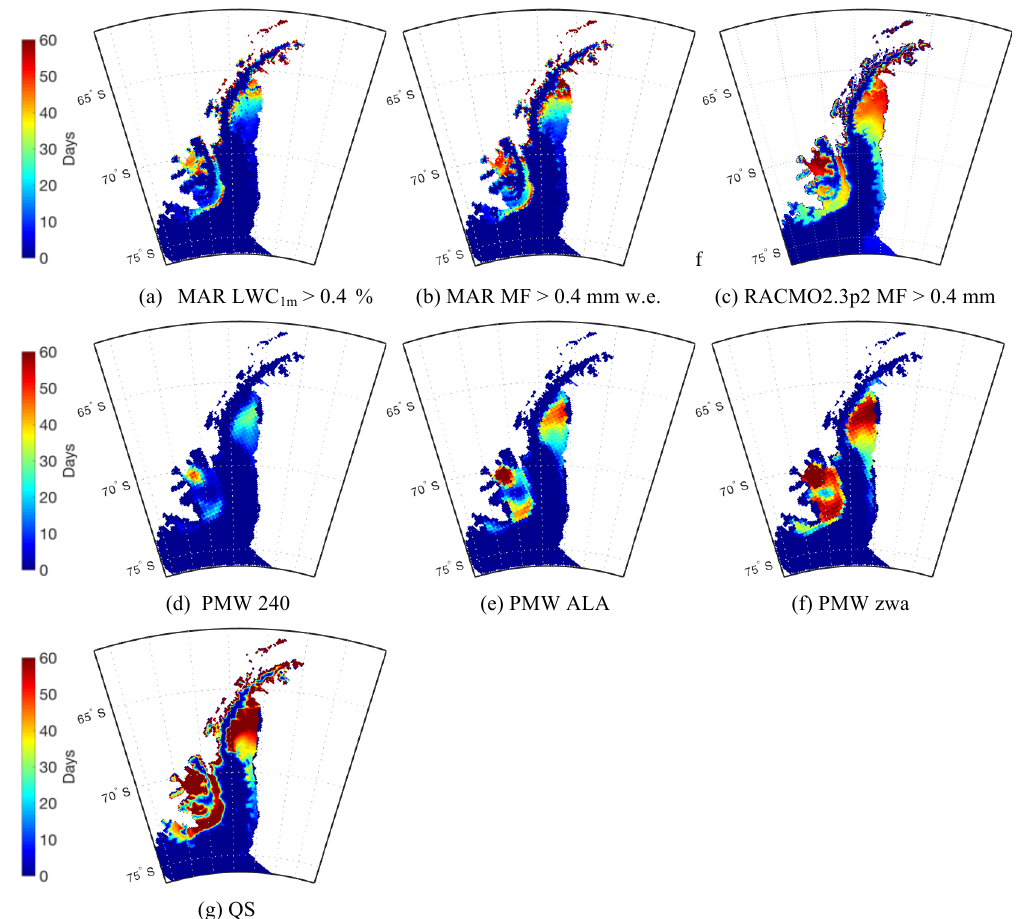
Figure 5. Average number of melt days (2000–2009) from multiple sources (a) MAR, liquid water content > 0 . 4% for three consecutive days. (b) MAR total melt flux > 0 . 4mmw.e. for 1 day or more (c) RACMO2.3p2, Melt Flux > 0 . 4mmw.e. Satellite-based metrics include (d) PMW 240 algorithm, (e) PMW ALA, and (f) PMW Zwa (g) QuikSCAT. All satellite-based estimates include a melt day only when part of a sustained three-day period of